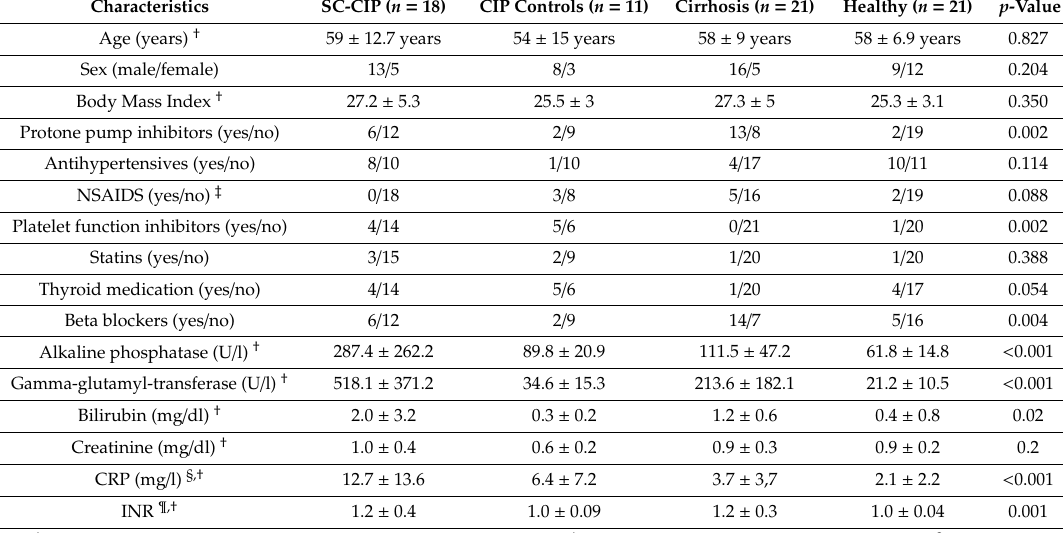
Table 1. Baseline characteristics for Secondary Sclerosing Cholangitis in Critically Ill Patients (SC-CIP), patients after critical illness without liver disease (CIP controls), cirrhosis and healthy controls including age, sex, body mass index, most frequently taken drugs during sample acquisition and